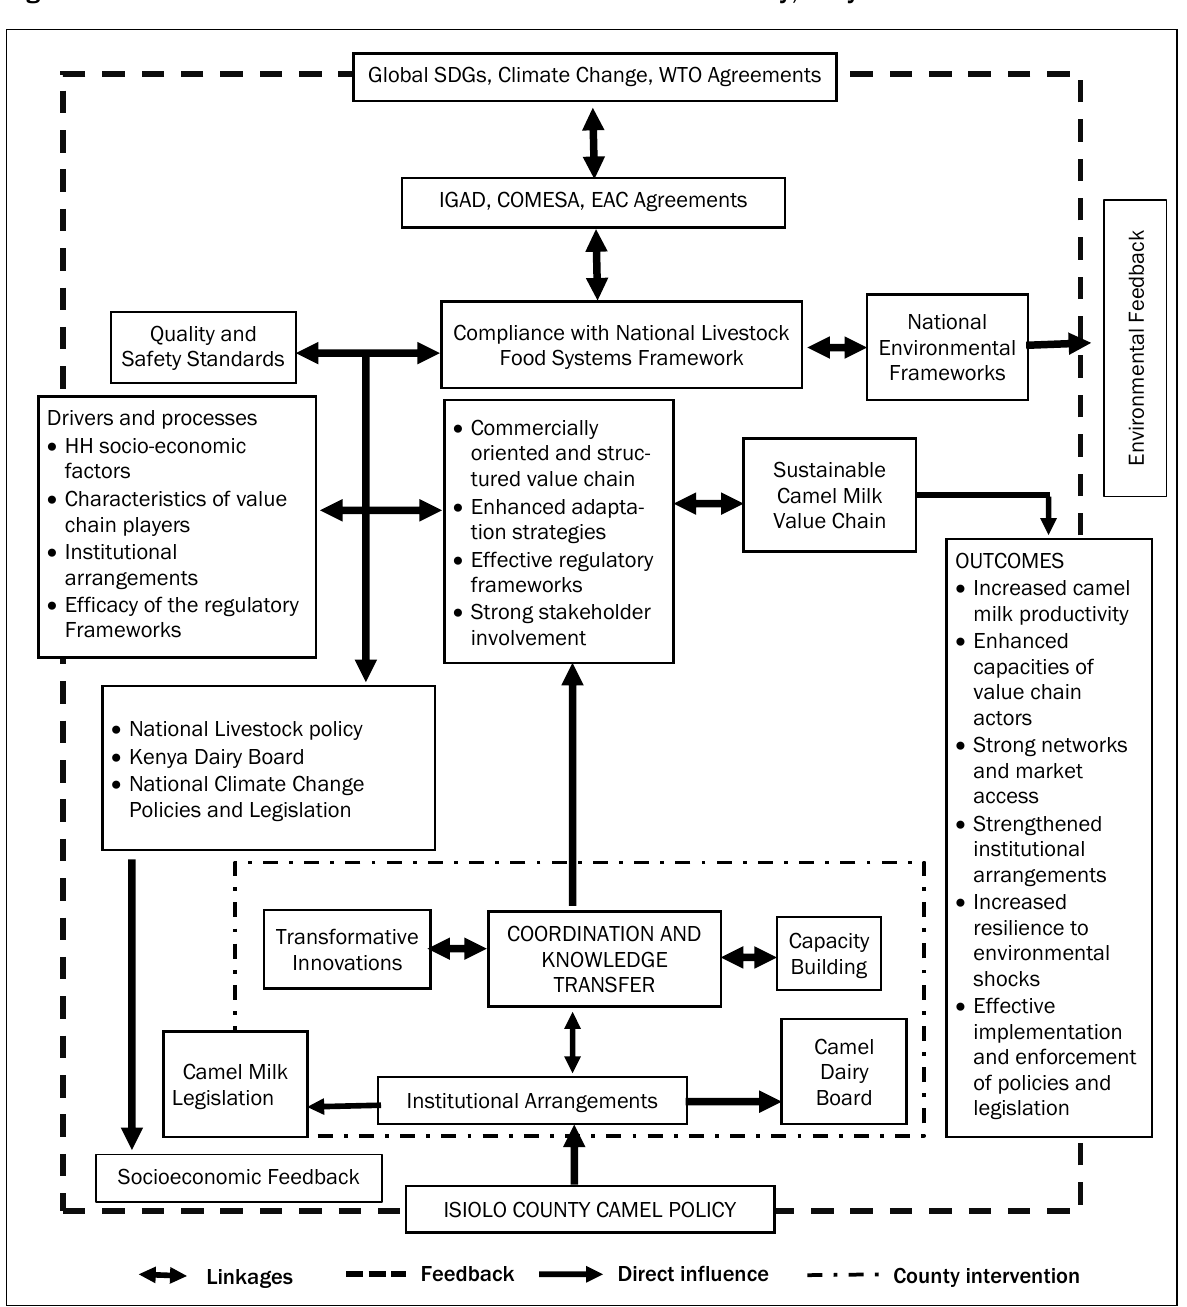
Figure 4. Model for Sustainable Camel Milk Value Chain in Isiolo County,